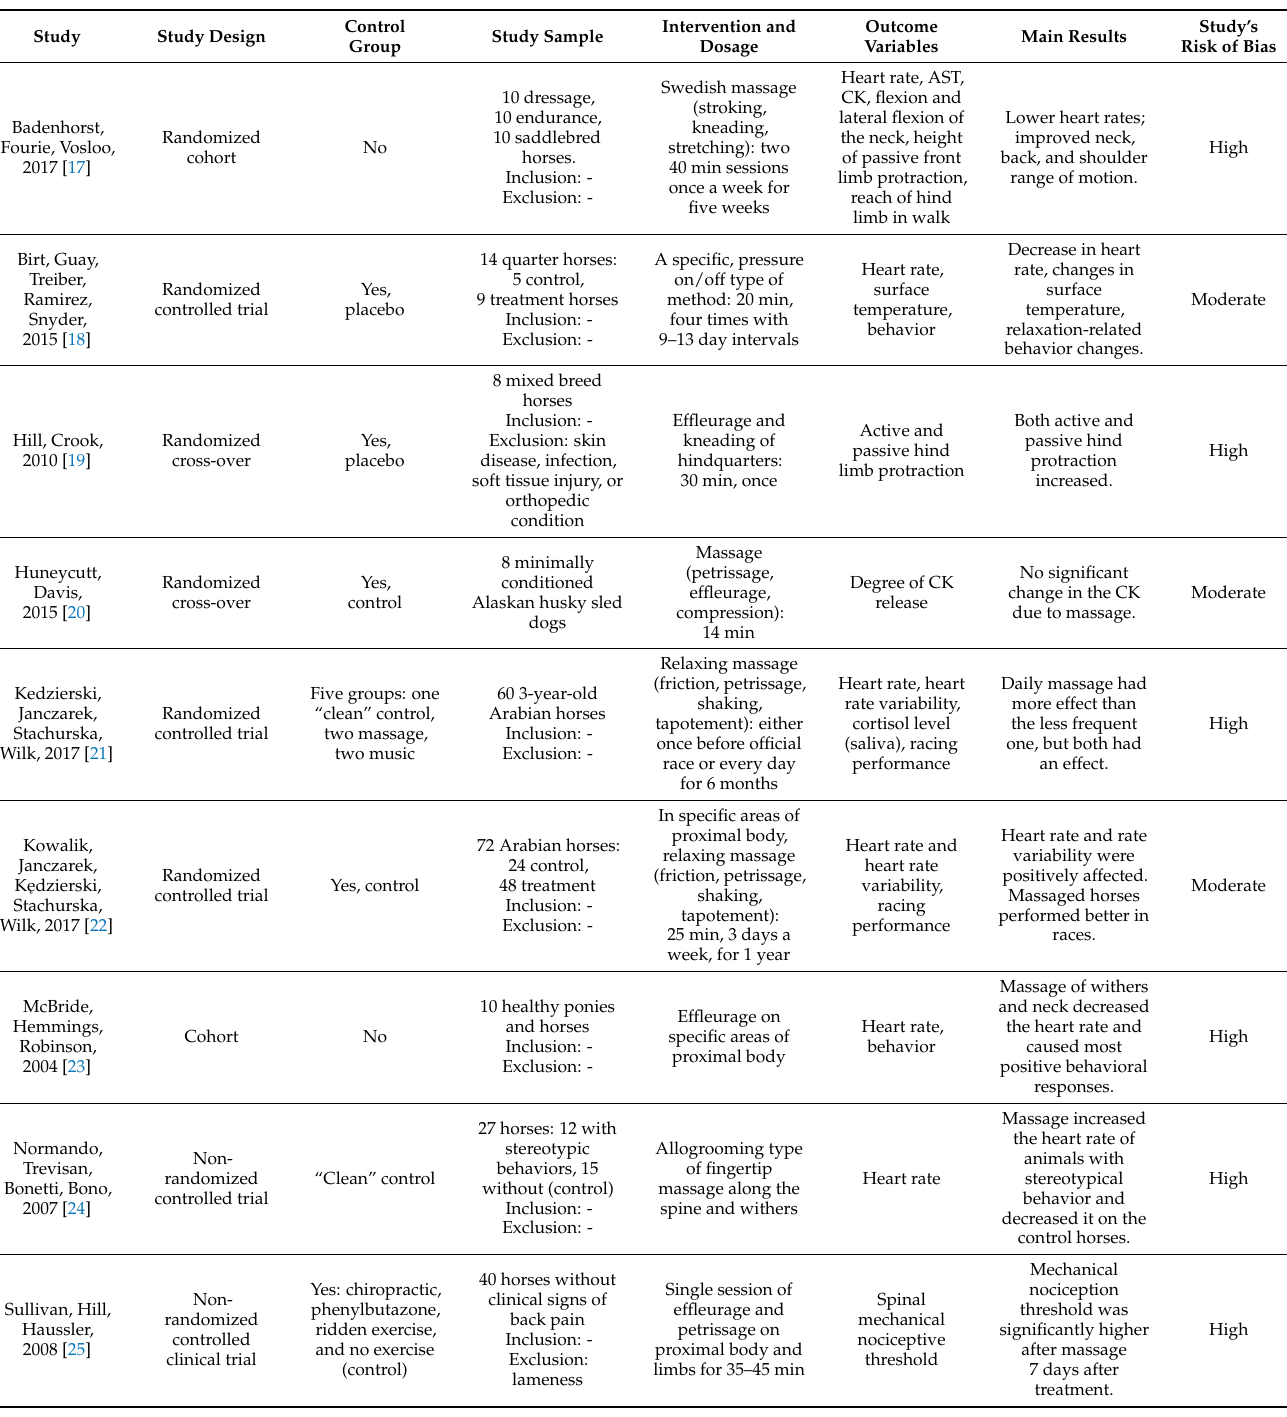
Table 1. Summary of studies regarding massage techniques, based on a systematic review of pub- lished